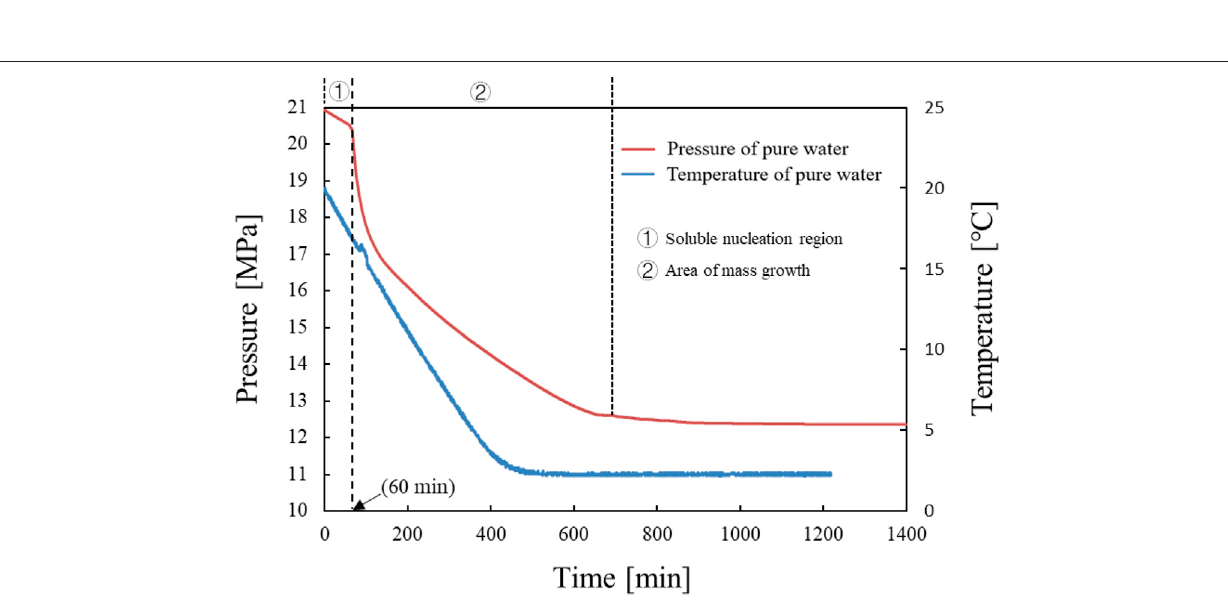
Frontiers in Energy Research |